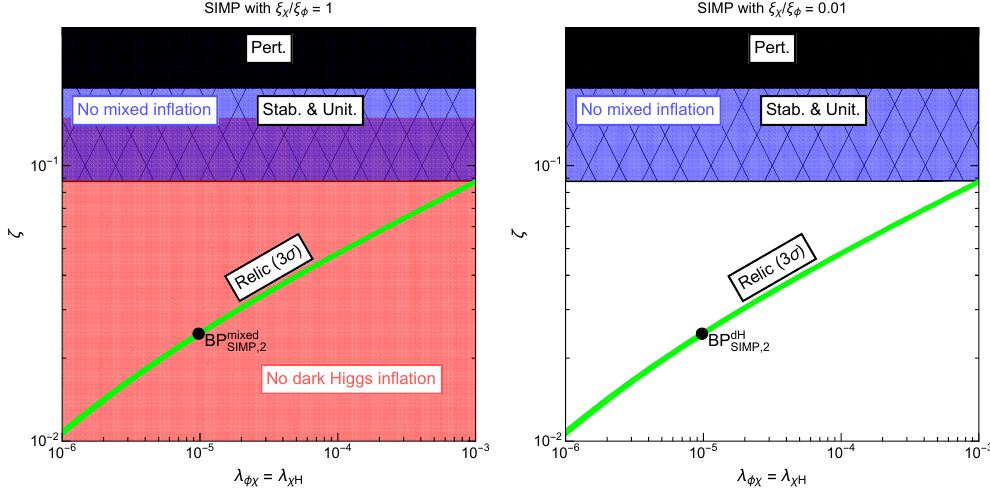
Figure 5 . Parameter space for SIMP dark matter scenario with (cid:24) (cid:31) =(cid:24) (cid:30) = 1 (left) and 0 : 01 (right), for (cid:21) (cid:30)(cid:31) = (cid:21) (cid:31)H versus (cid:16) . The input parameters and color codes are as in (cid:12)gure 4, except that (cid:21) (cid:31) = (cid:21) (cid:30) = 0 : 1 and (cid:16) is varying.